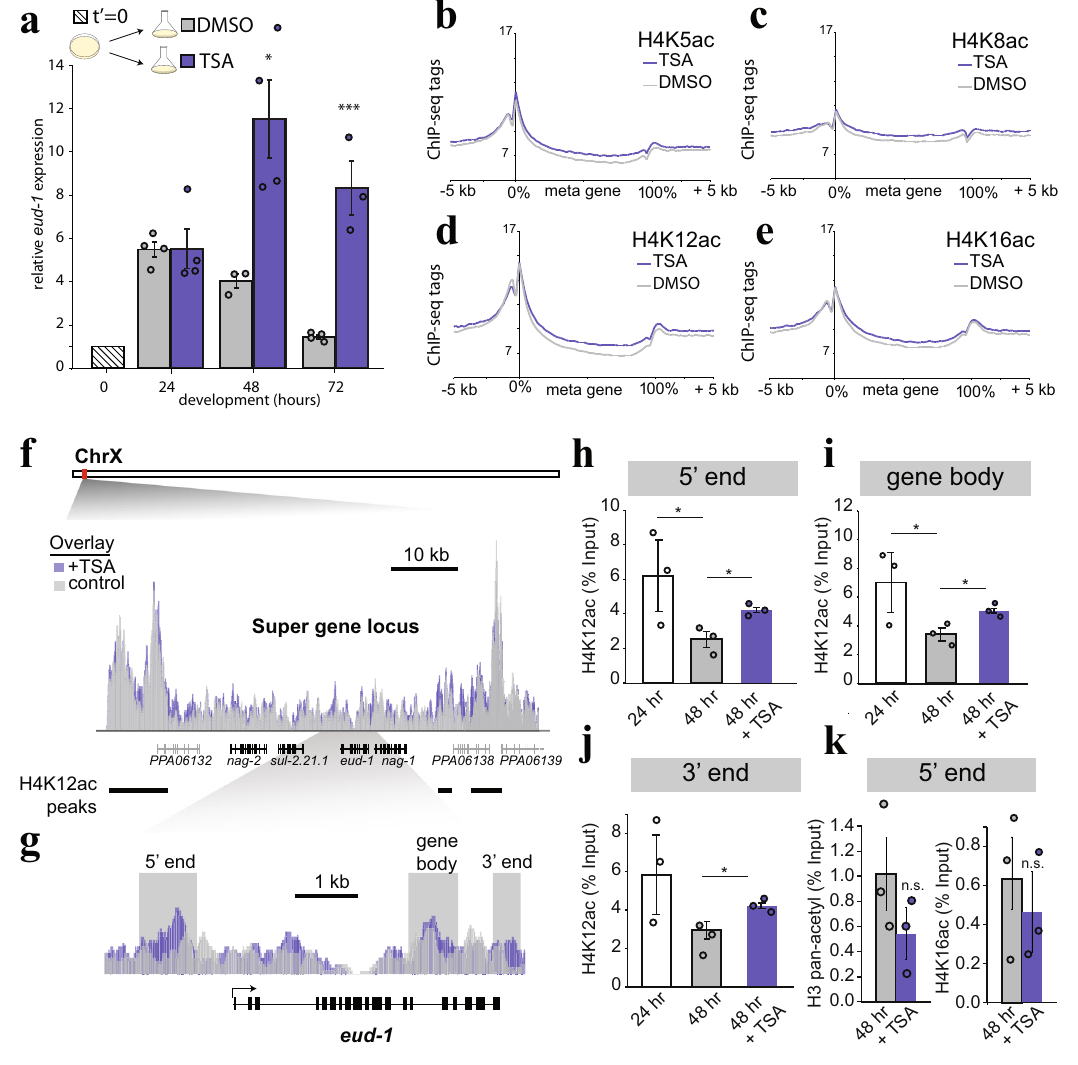
Fig. 3 | H4K12ac acetylation/deacetylation at switch genes determines plasti- cityandcanalization,respectively.a , eud-1 expressionatindicatedtimepointsby RT-qPCR with either DMSO or TSA added directly after bleach synchronization. Error bars represent S.E.M. of 4 biologically independent replicates except for DMSO 48h and TSA 72h where n =3. Statistical signi fi cance was determined by student ’ s 1-tailed t -test. P -values for 48-h comparisons=0.0089, and 0.00062 for 72-h comparisons; * p <0.05, ** p <0.01, *** p <0.001. b – e ChIP-seq meta-gene pro- fi les of H4-acetylated residues at 48h in +/- TSA. y-axis represents average input- normalized ChIP-seq tag counts per bp per gene, and the x -axis represents 5' to 3' gene coordinates divided into 200 bins +/ − 5 kb, n =2. f ChIP-seq tag density of H4K12ac over the multi-gene locus (black genes) that control mouth-form